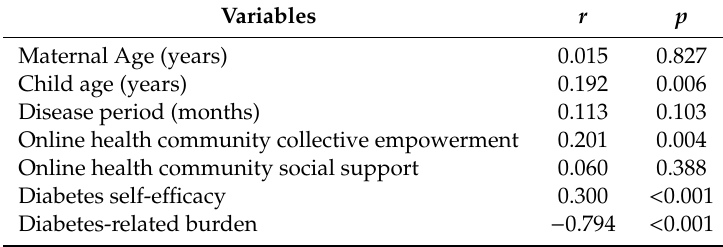
Table 3. Correlation between continuous demographic variables, online health community collective empowerment (OHCE), online health community social support (OHSS), diabetes self-e ffi cacy (DSE), and diabetes-related burden (DRB), and QOL ( N = 208).